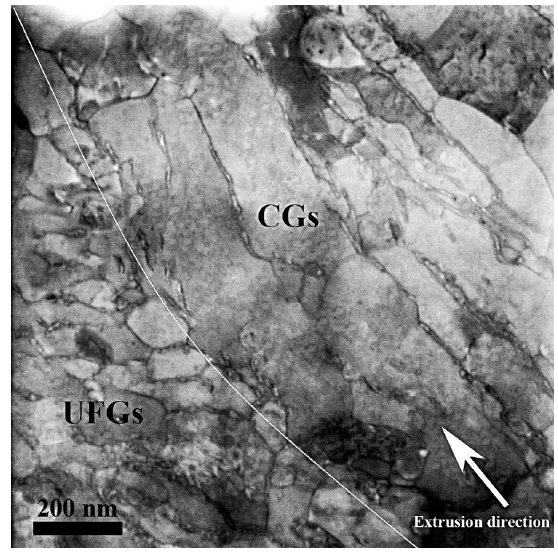
Figure 2. Scanning transmission electron microscopy (STEM) image of the bimodal sample at the interface of CG and UFG region.